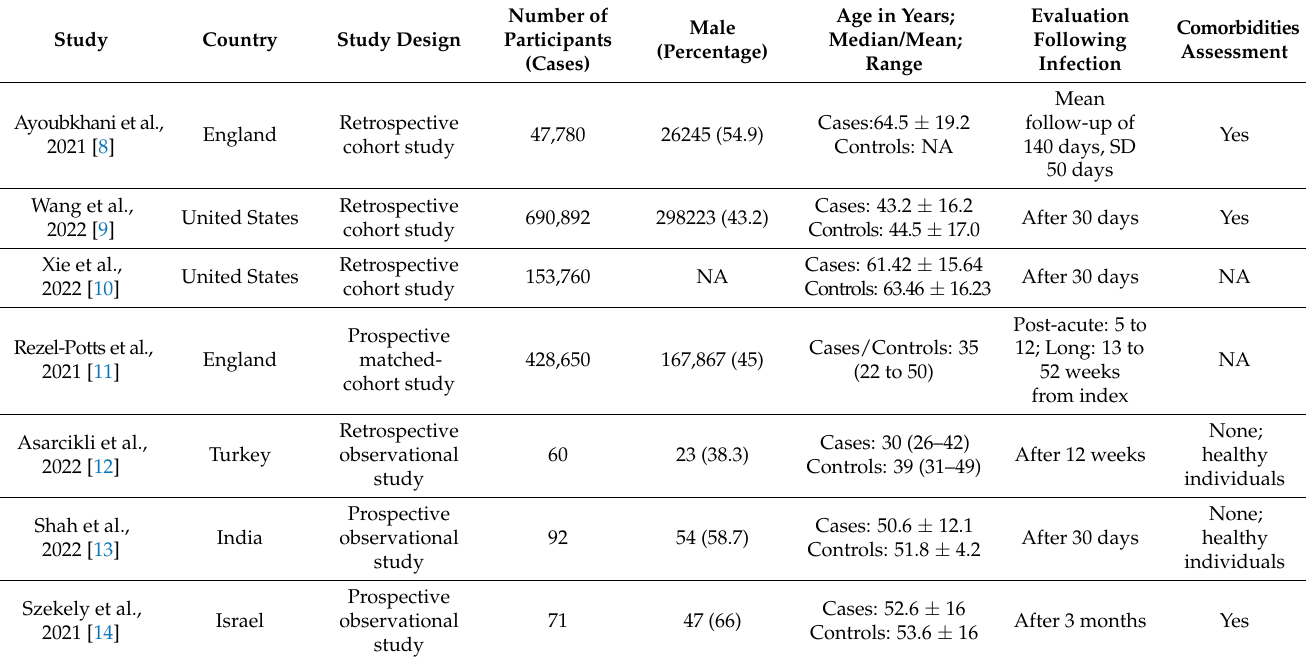
Table 1. Baseline study